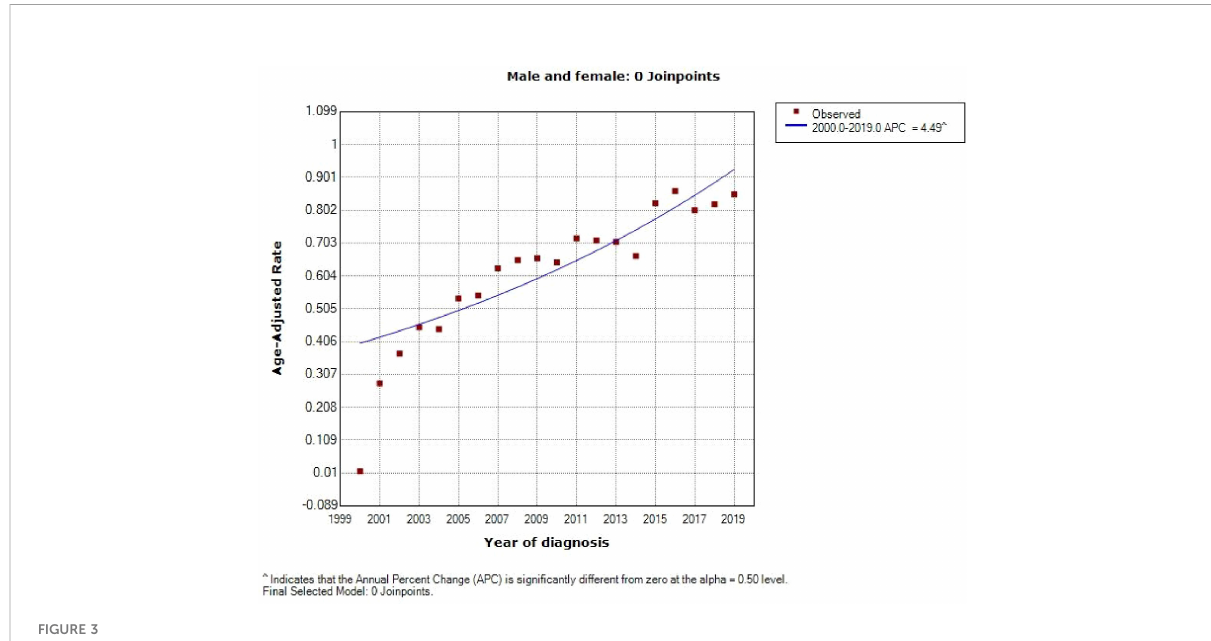
FIGURE 3 Diagnosis rate curves for chRCC patients from 2000 to